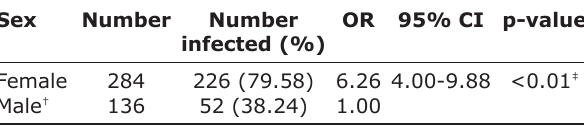
Table-1: Prevalence (%) of ovine Anaplasma infection between sexes in North